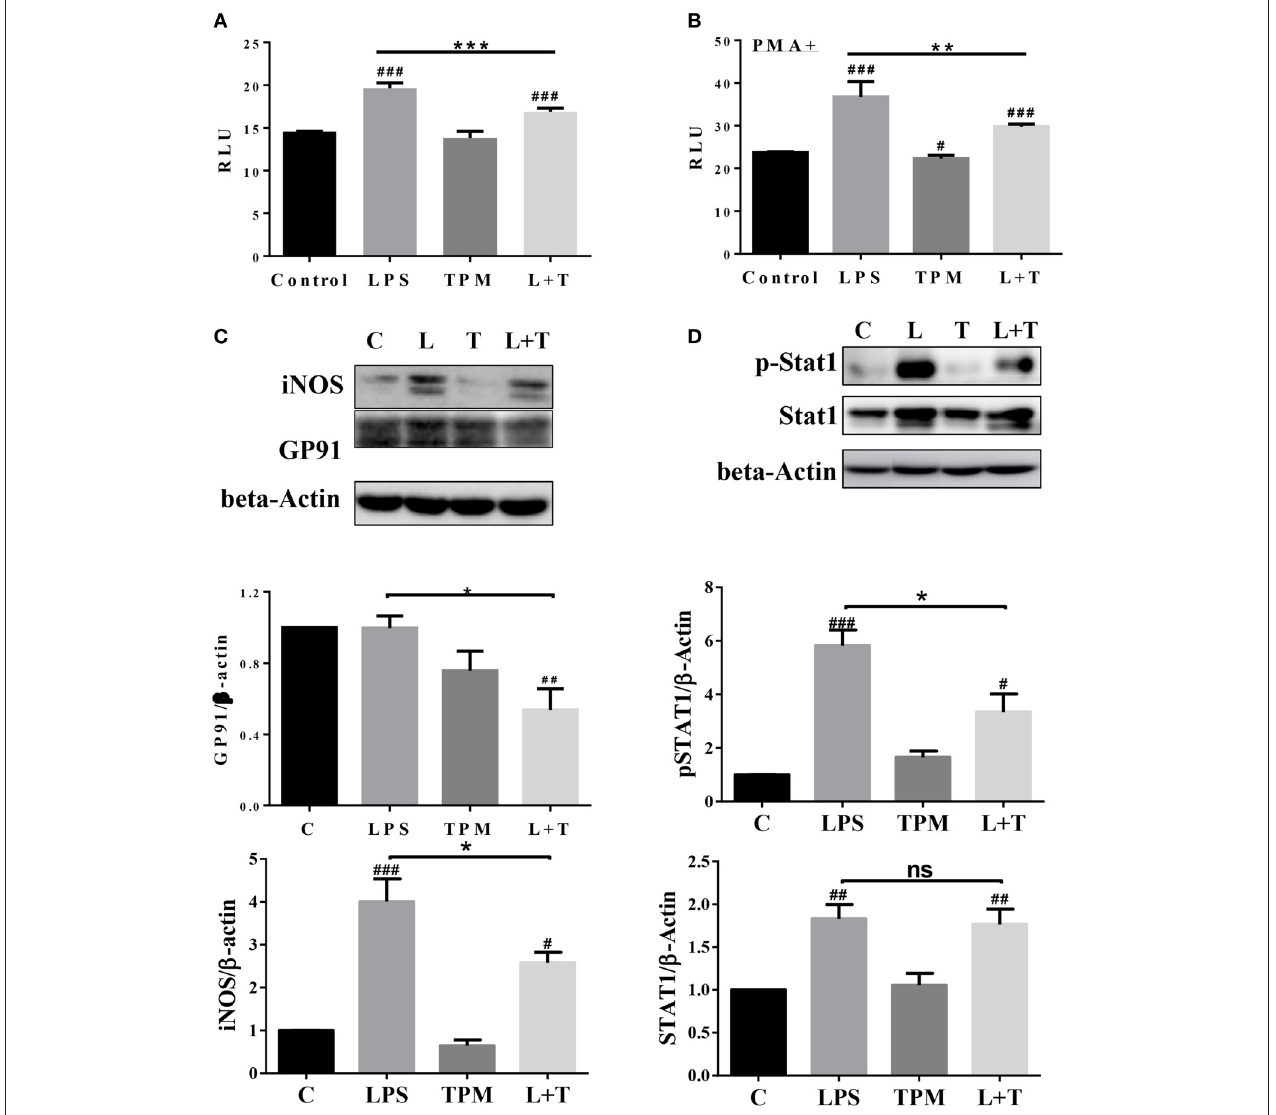
FIGURE 5 | TPM decreased the levels of iNOS, NADPH oxidase component GP91, and STAT1 activation in LPS-primed neutrophils. Purified neutrophils were treated with LPS (100ng/ml) and/or TPM (70ng/ml equi-nicotine units) overnight, followed without (A) or with (B) stimulation of PMA (20ng/ml) for 15min, then subjected to